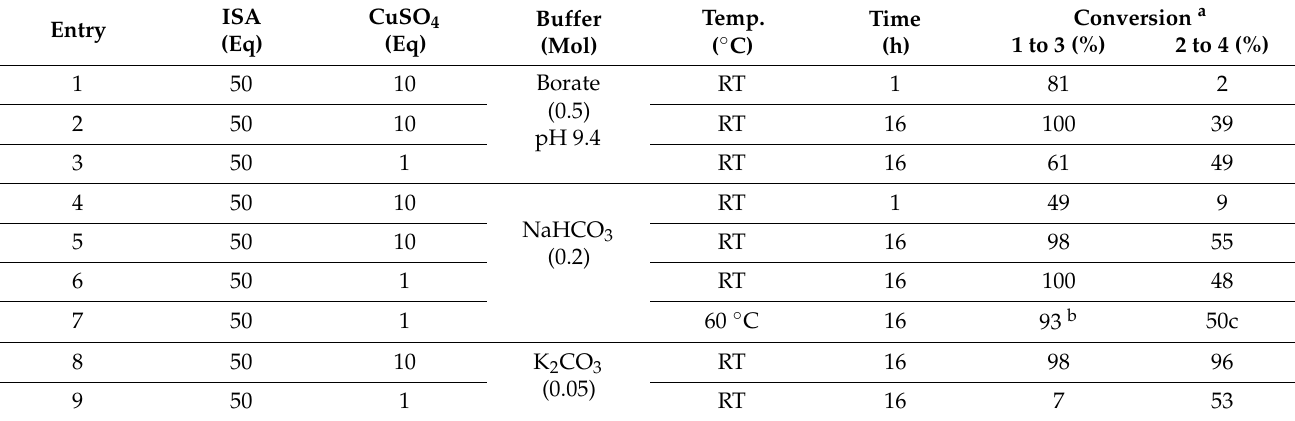
Table 1. Selected optimization results for the diazo-transfer reaction on DNA. Reactions conducted at 0.7 mM on 10 nmol